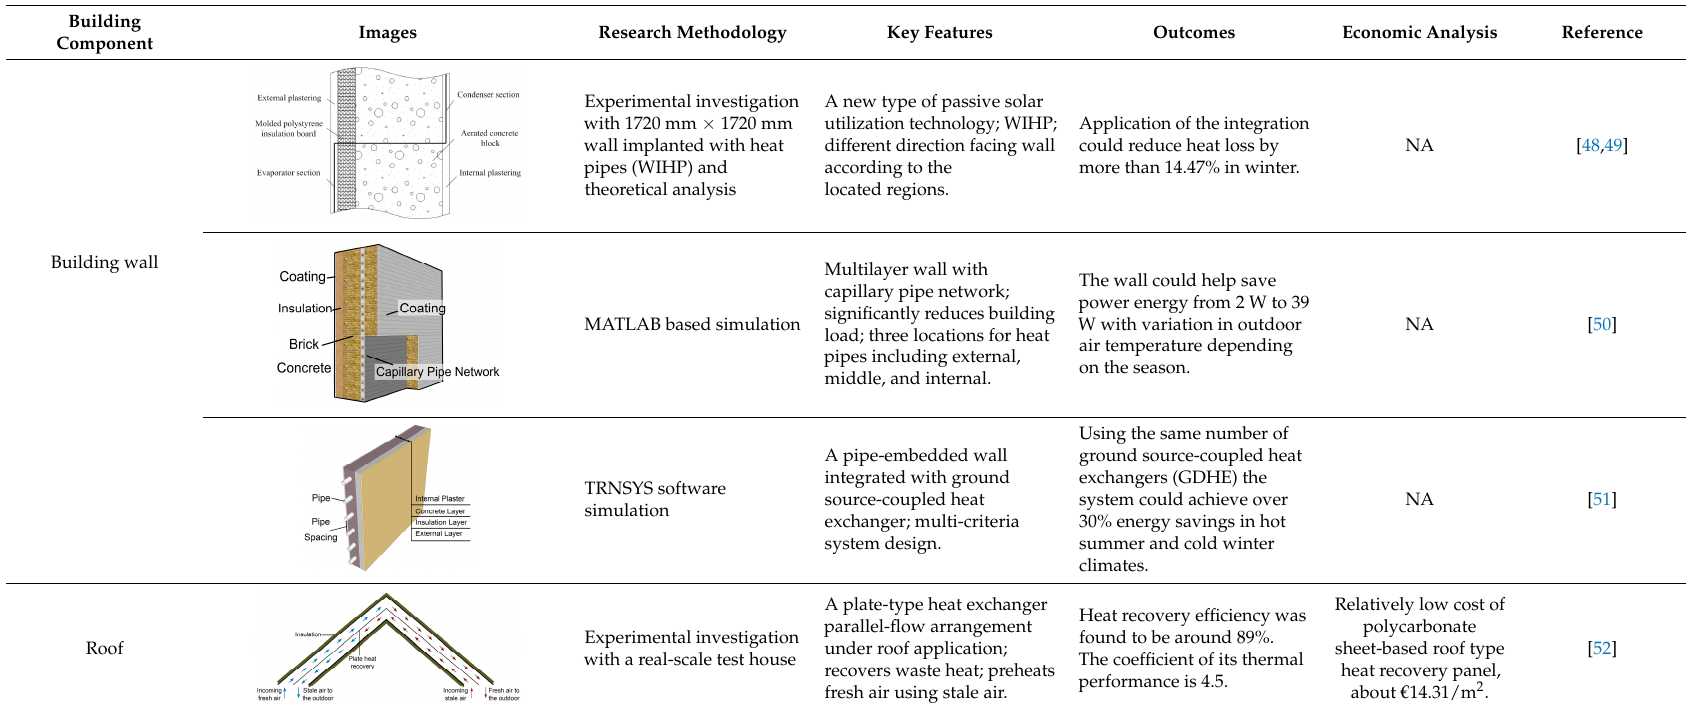
Table 2. A summary of heat recovery systems integrated into building components.